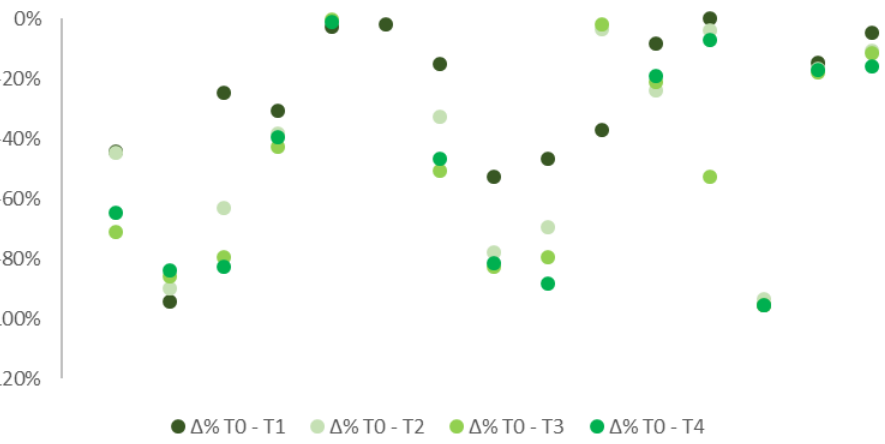
Figure 1. % difference in pain median levels at T0, T1, T2, T3, and T4 in all patients, with both FS and ONP.